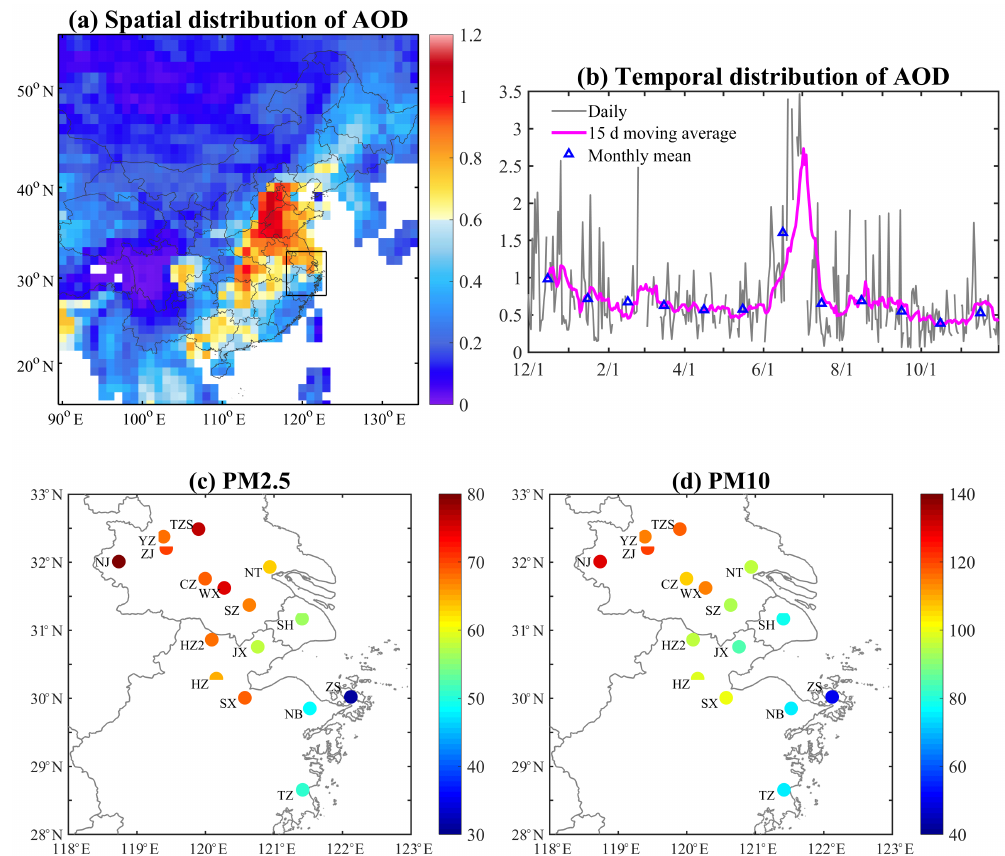
Figure 2. The spatial distribution of annual mean AOD values (at a wavelength of 550nm) over the YRD (a) , the temporal variations in regional average AOD values over 28–33 ◦ N and 118–123 ◦ E (b) , the spatial distribution of annual mean PM 2 . 5 concentrations (c) , and the spatial distribution of annual mean PM 10 concentrations (d) . In (b) , the gray line represents the daily value, the blue markers represent the monthly mean values and the magenta line represents the 15-day moving average value. In (c) and (d) , the acronyms of each city are